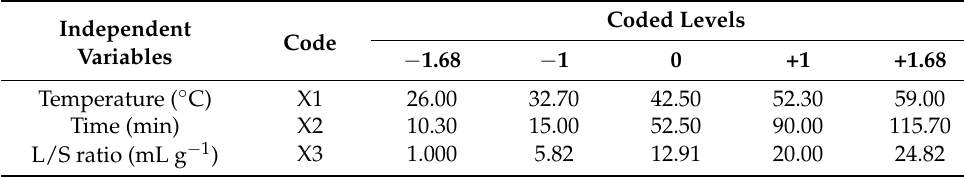
Table 1. Independent variables values for